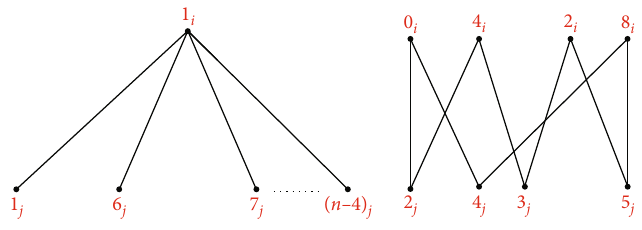
i , j ∪ K 8 1, n − 8 Þ